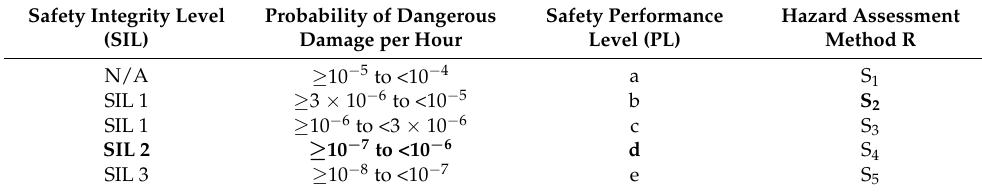
Table 1. The result of the analysis designed to determine the level of the safety function. Safety Integrity Level